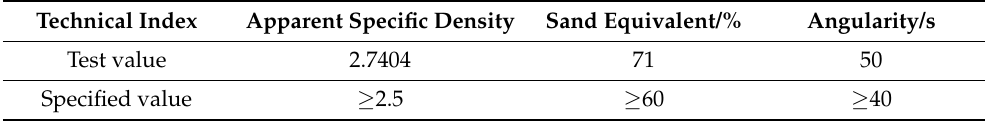
Table 5. Basic technical indexes of fine aggregate Table 6. Basic technical indexes of mineral powder [13].